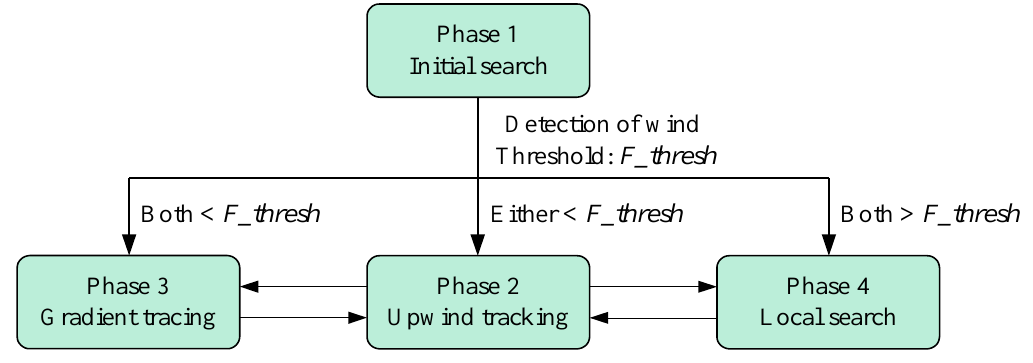
Figure 4. Block diagram of multi-sensor fusion step-by step search